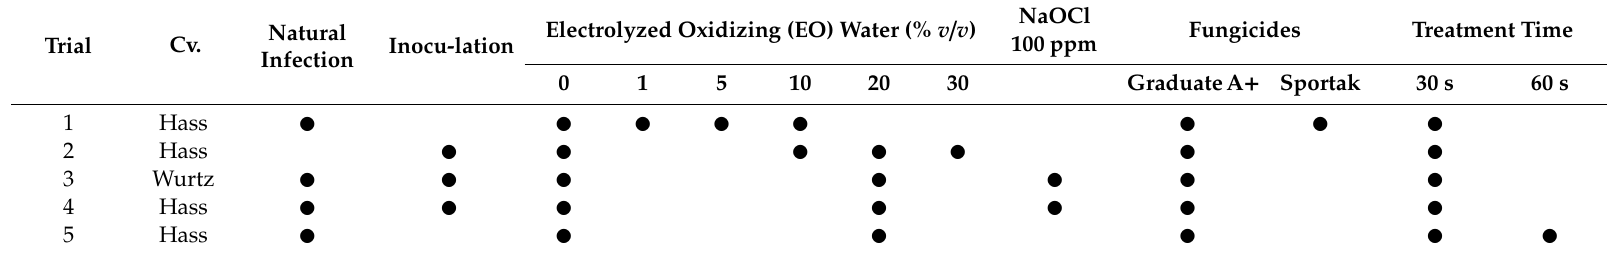
Table 1. Summary of trials undertaken with harvested avocado